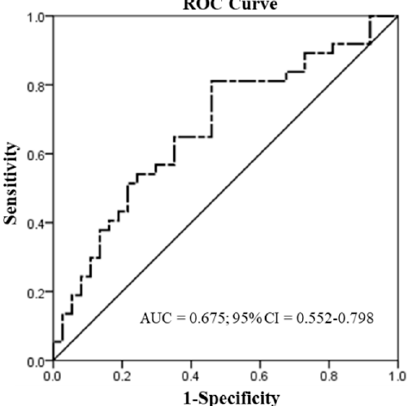
Figure 1. Expression of CYP26A1 in human oral and pharyngeal cancer tissues. ( A ). The relative mRNA (2 − ∆∆ Ct ) expression of CYP26A1 (n = 34) in human oral and pharyngeal tumor (T) tissues compared with their adjacent normal (N) tissues. ( B ). In human oral and pharynx tumor (T) tissues compared with their adjacent normal (N) tissues (representative cases are shown with β -actin as the protein loading control), the protein levels were examined by Western blotting and quantitated using Image J (n = 10). The results are represented as the median (IQR). The boxes denote the interquartile ranges, while the bars represent the highest and lowest values, excluding outliers and extreme outliers. ** p < 0.01 compared to the normal group.